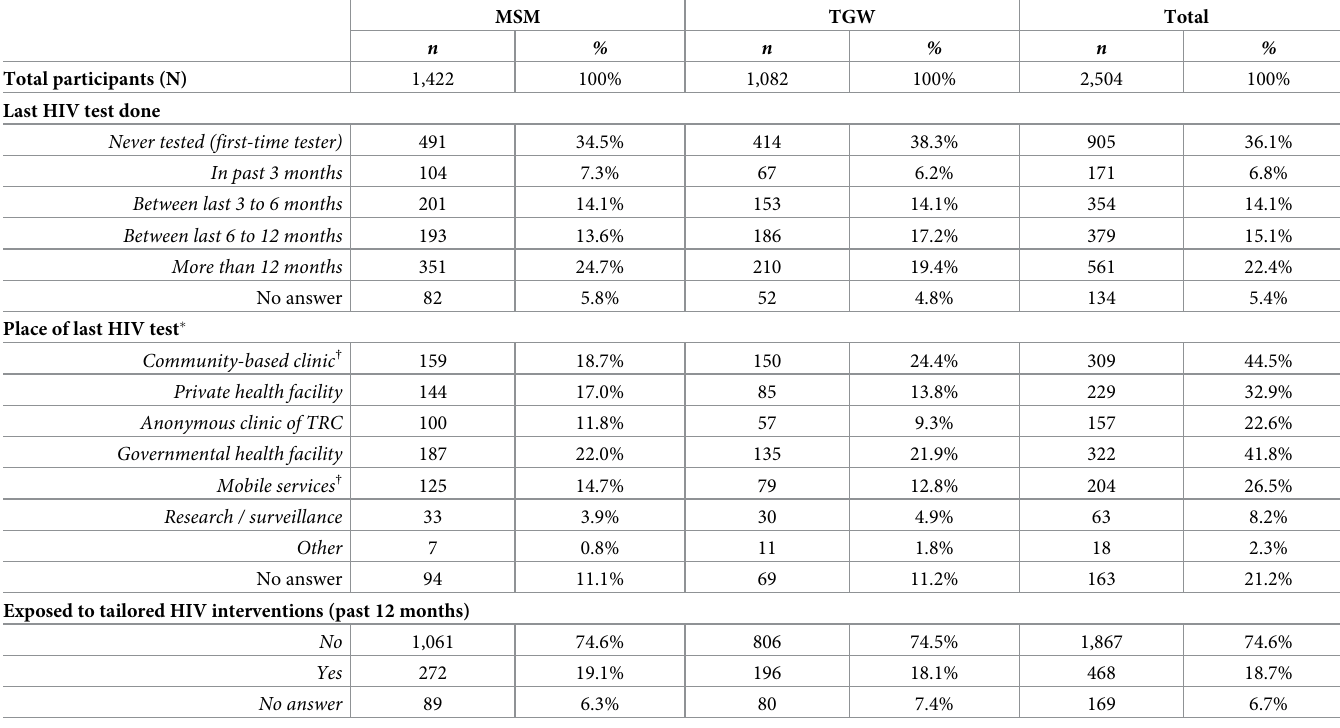
Table 3. History of HIV testing and exposure to interventions.